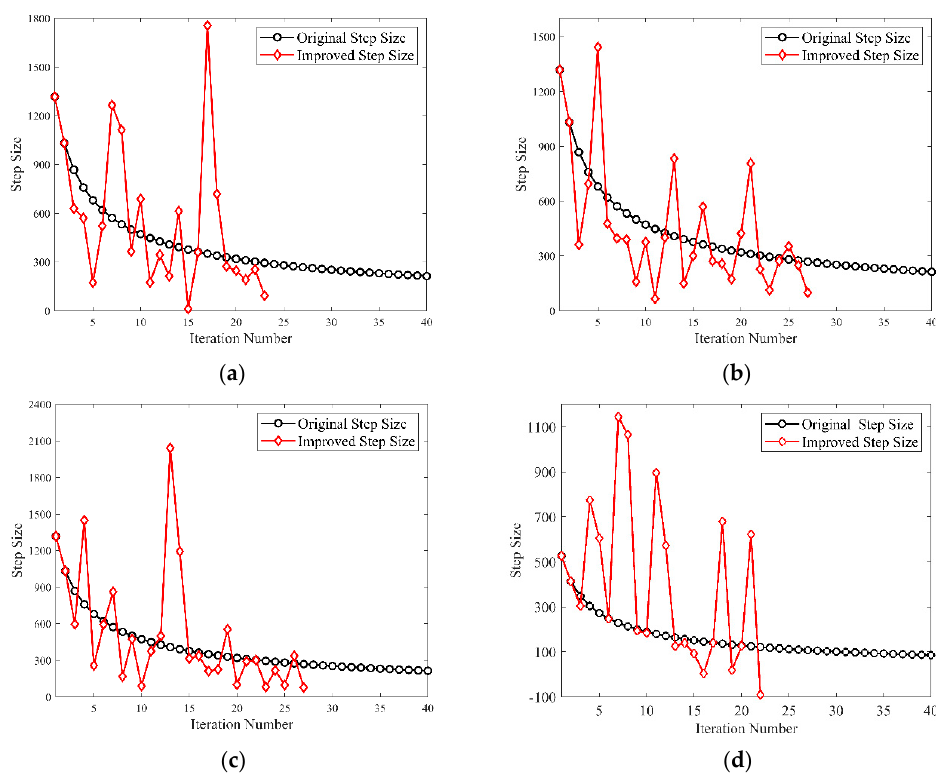
Figure 13. Trajectories of step size change: (a) 5% FP; (b) 30% FP; (c) 50% FP; (d) 100% FP.